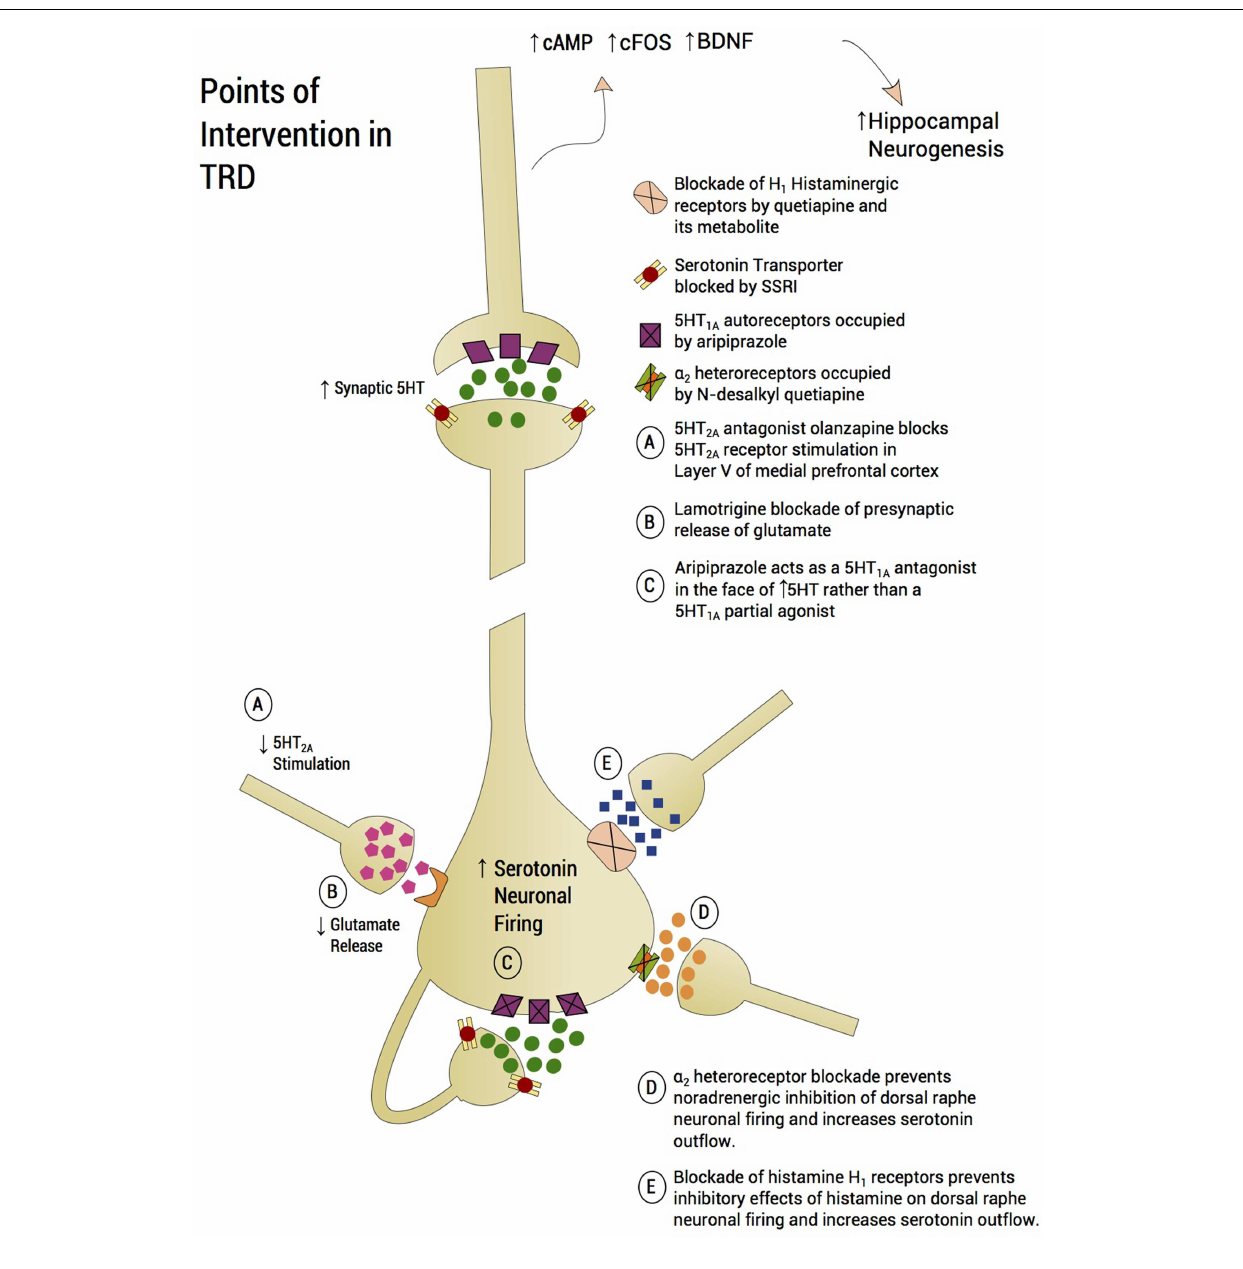
FIGURE 4 | Points of intervention inTRD . A treatment approach on a plausible neurobiological model is proposed, which aims to prevent mPFC-induced serotonin shutting down the dorsal raphe. Utilizing an incremental approach, lamotrigine is recommended as a first step to